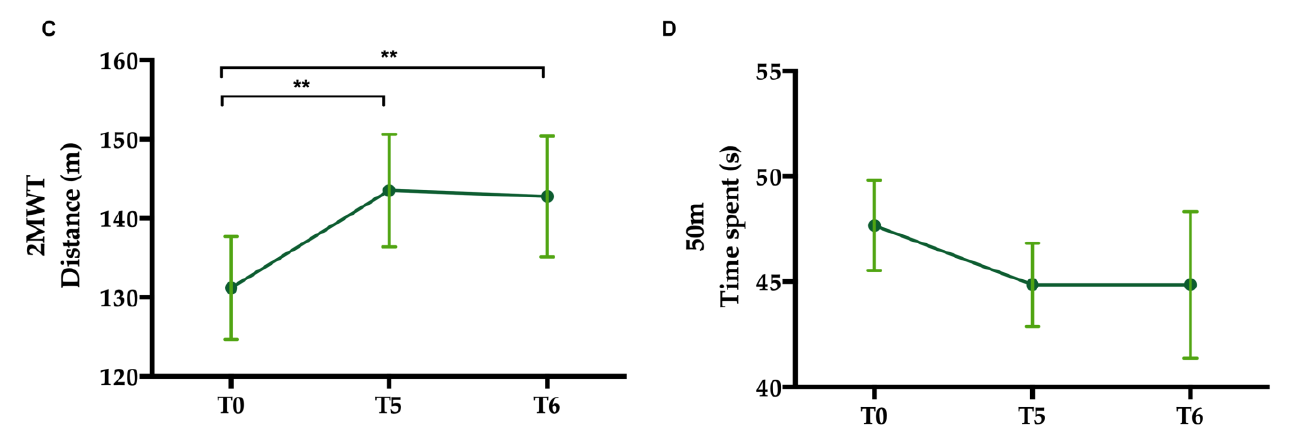
Figure 3. Gait measures for all PwMS pooled. ( A ) Change in functional gait assessment (FGA) scores at T5 and T6 relative to baseline. ( B ) Change in time for the timed-up and go (TUG) at T5 and T6 relative to baseline. ( C ) Distance walked in 2 min at T0, T5, and T6. ( D ) Time taken to complete the 50 m overground walking test at T0, T5, and T6. Note. Error bars represent the standard error of the mean. * p < 0.05; ** p < 0.01. Table 4. Repeated measures ANOVA examining the effect of session on FGA scores, time on the TUG and 50mWT, and distance on the 2MWT at T0, T5, and T6 (upper part of the table). Paired- samples t -tests examining the changes from baseline in FGA score, time on the TUG and 50mWT, and distance on the 2MWT (difference between T5 and T6; lower part of the table). Pooled data across all PwMS.